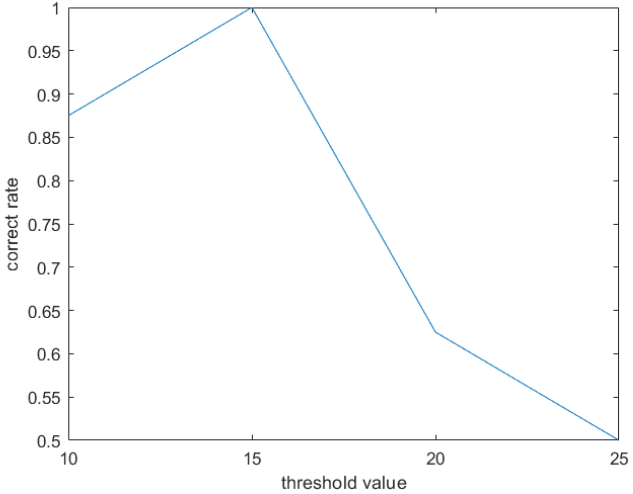
Figure 6. The comparison of threshold t 1